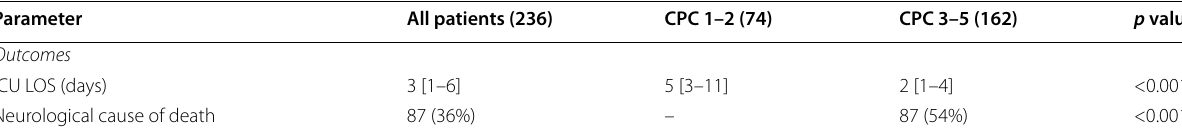
Table 2 Logistic regression analysis to identify predictors of poor neurological outcome (CPC 3–5) at 3 months